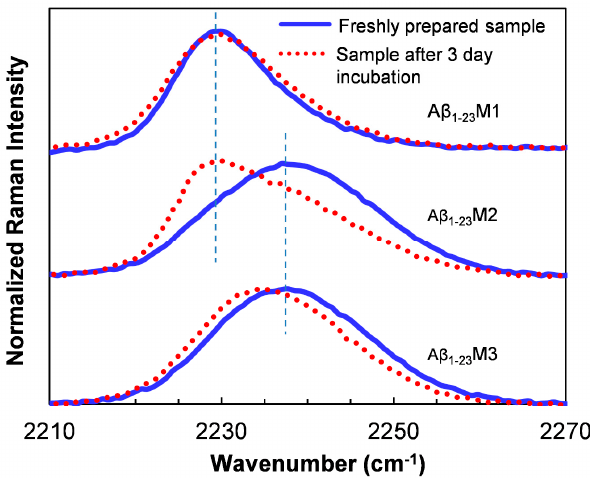
Figure 4. Raman spectra of three A β 1–23 mutants before and after being incubated for 3 day for aggregation [172]. In the mutants, the Phe CN residue was used to replace Tyr10 (A β 1–23 M1), Phe19 (A β 1–23 M2), and Phe20 (A β 1–23 M3), respectively. The vertical dashed lines indicate Raman wavenumbers at 2229 and 2237 cm − 1 , respectively. Reprinted with permission.